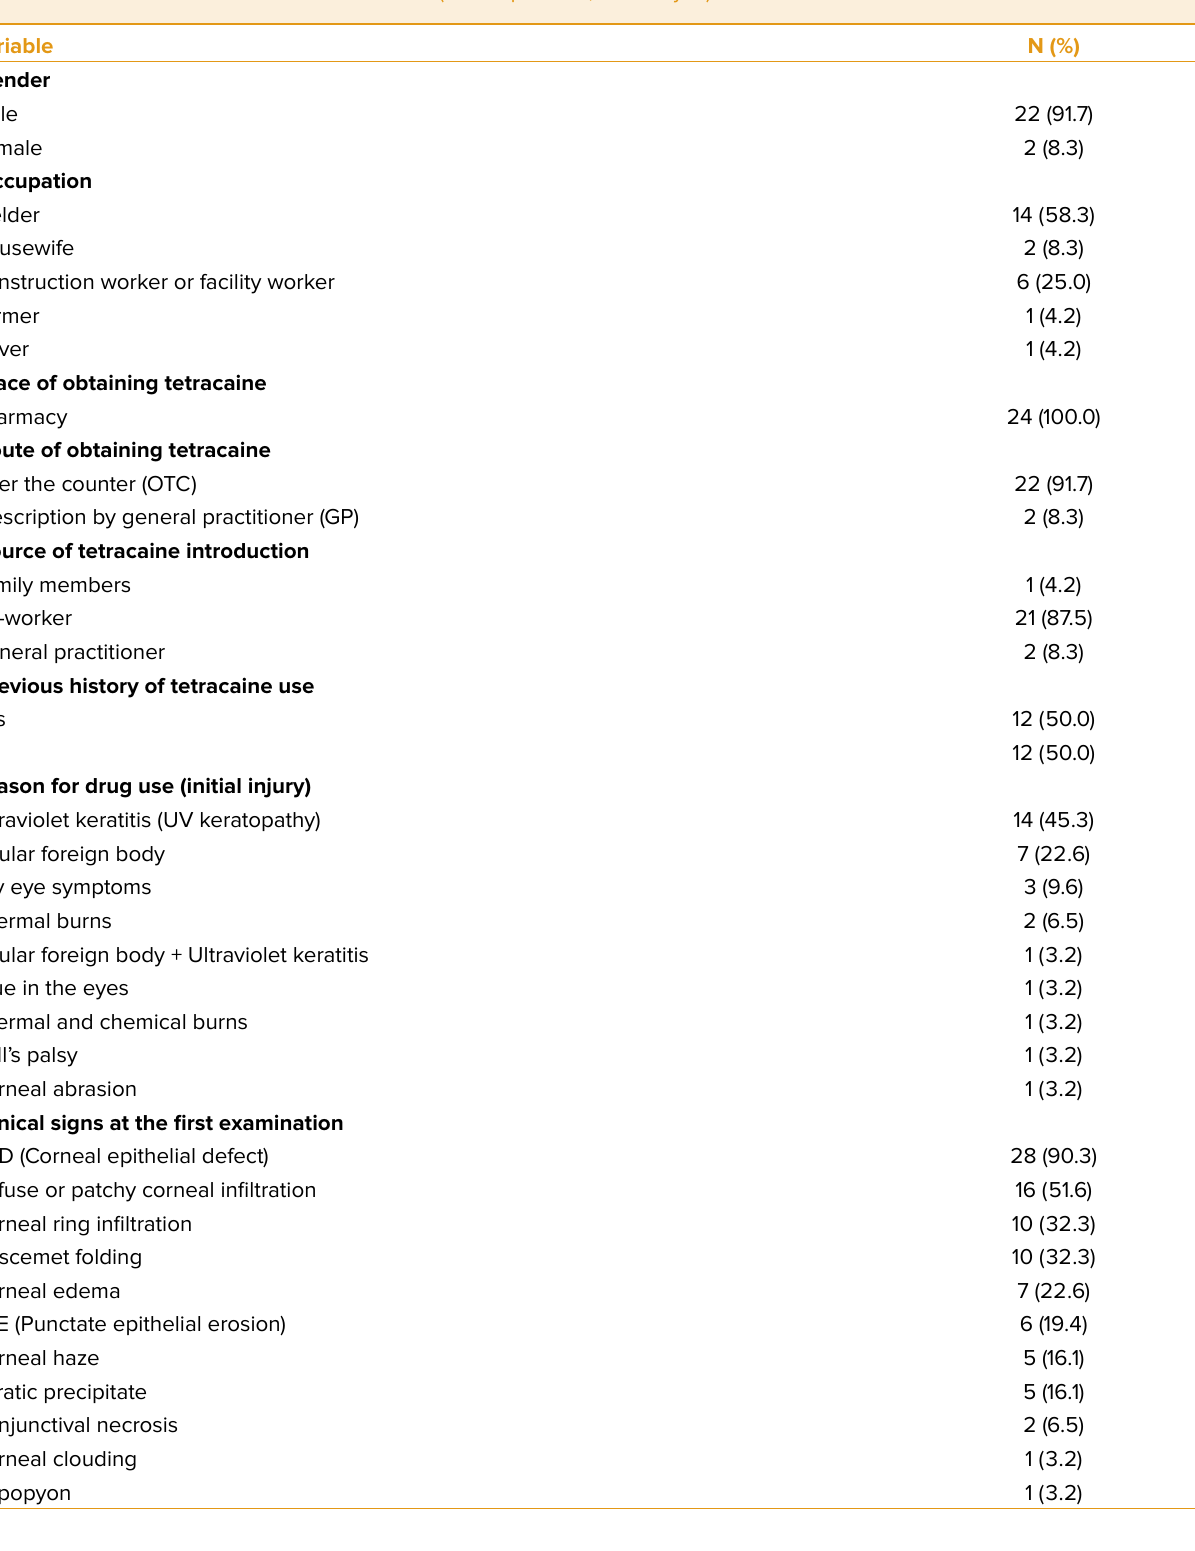
Table 1. Demographic characteristics, reason of drug misuse (initial injury), and clinical findings at the first examination and patient’s main complaints and symptoms of the patients who were referred to eye emergency department for adverse drug reactions of tetracaine in the southeast of Iran ( n = 24 patients, n = 31